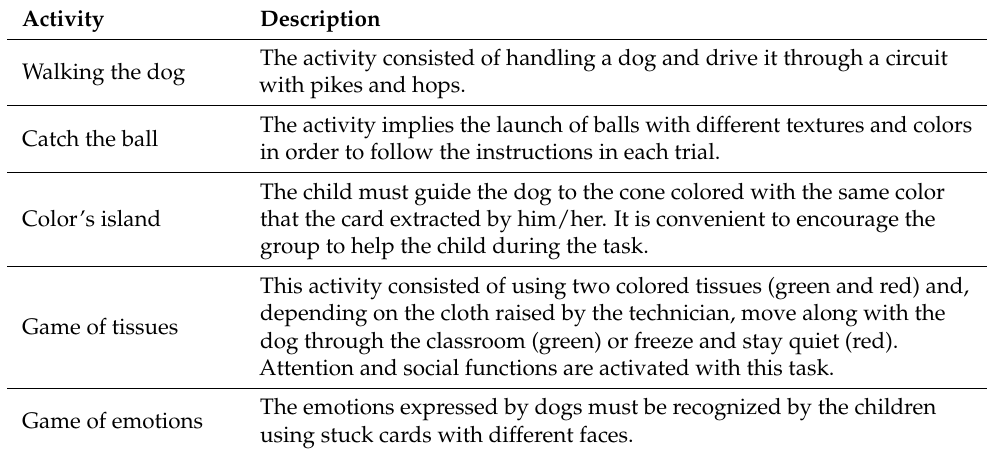
Table 1. Example of activities included in the dog-assisted education program “One dog, one happy child”. Activity